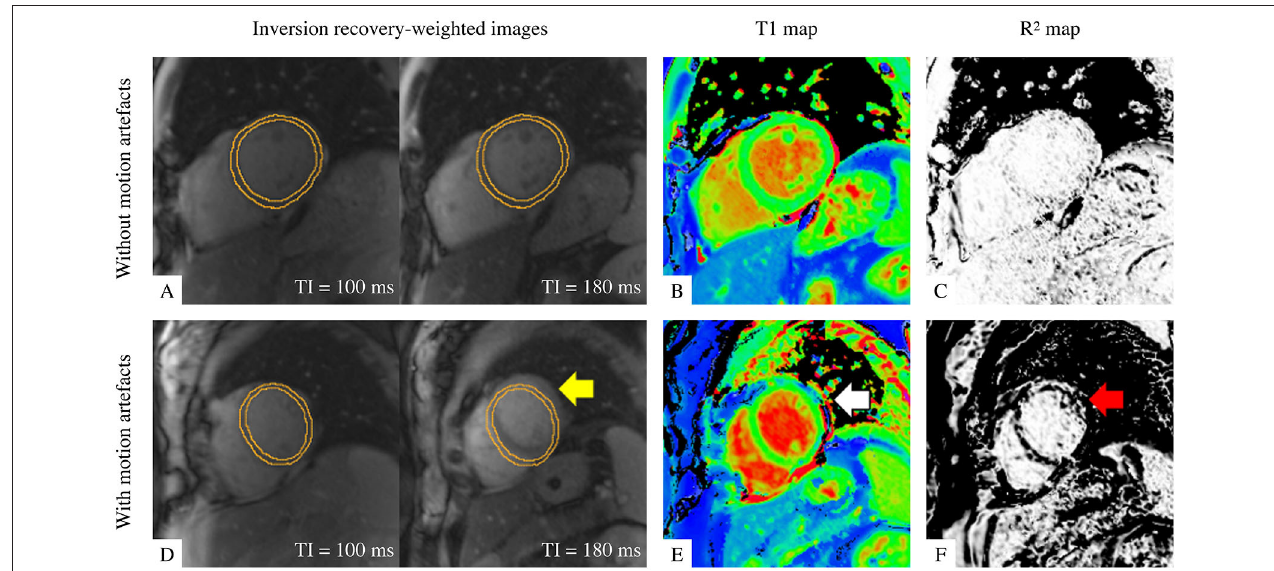
FIGURE 1 | Illustration of T1 maps with good quality (top row) and with motion artefact (bottom row). (A,D) Two examples out of seven of inversion-recovery weighted (IRW) images required for T1 map reconstruction are shown, time-stamped with their corresponding inversion times (TI) and overlaid by identical manual myocardial contours for identifying motion. (B,E) ShMOLLI T1 maps. (C,F) R 2 quality control maps. A good quality T1 map is indicated by (A) myocardium in same position and (C) “all white” in the left ventricular myocardium indicating high T1 fitting confidence. A T1 map with motion artefact is evident by misalignment in IRW images (yellow arrow), suspicious features in T1 map (white arrow) and dark bands in R 2 map in the left ventricular myocardium as evidence of poor T1 fitting (red